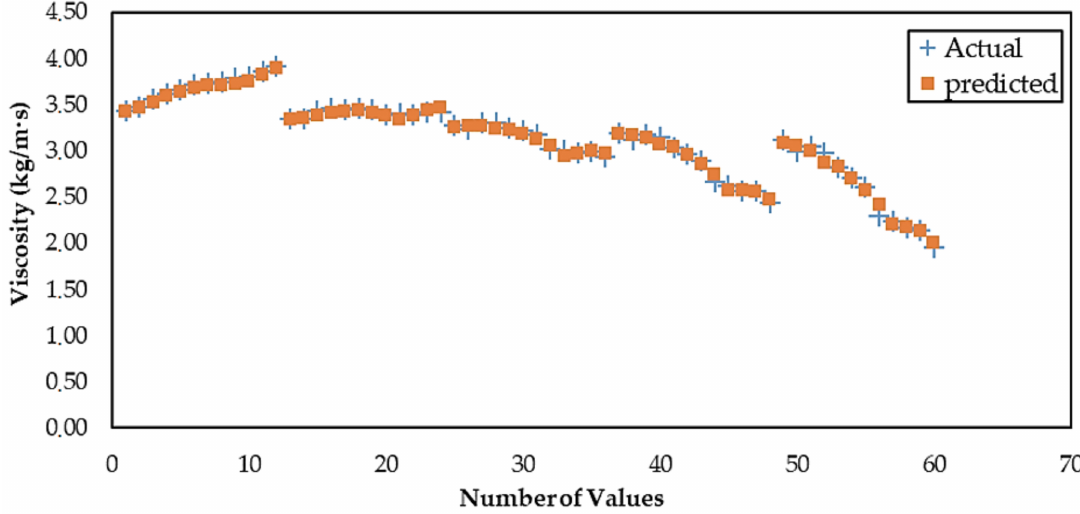
Figure 9. The actual viscosity values obtained with the experimental values and predicted viscosity values obtained using